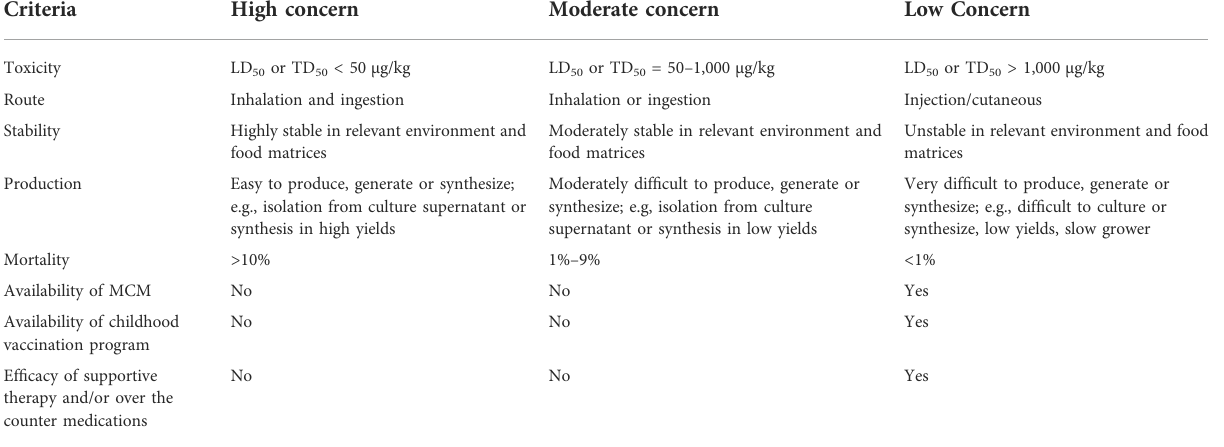
TABLE 2 Scoring de fi nitions for assignment of High, Moderate or Low Concern using the DSF.